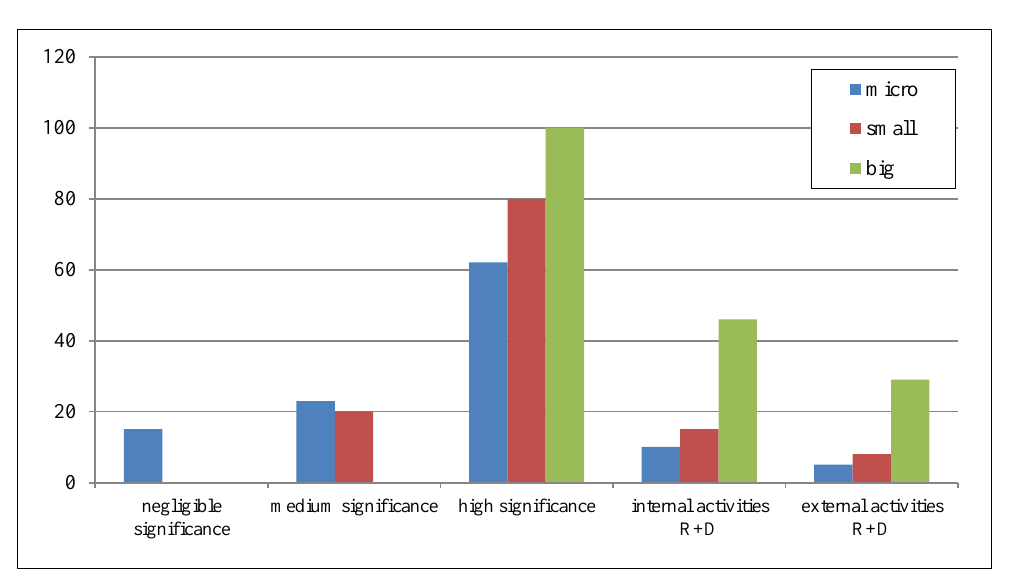
Figure 9. The importance of adaptation strategies in the energy sector and R+D